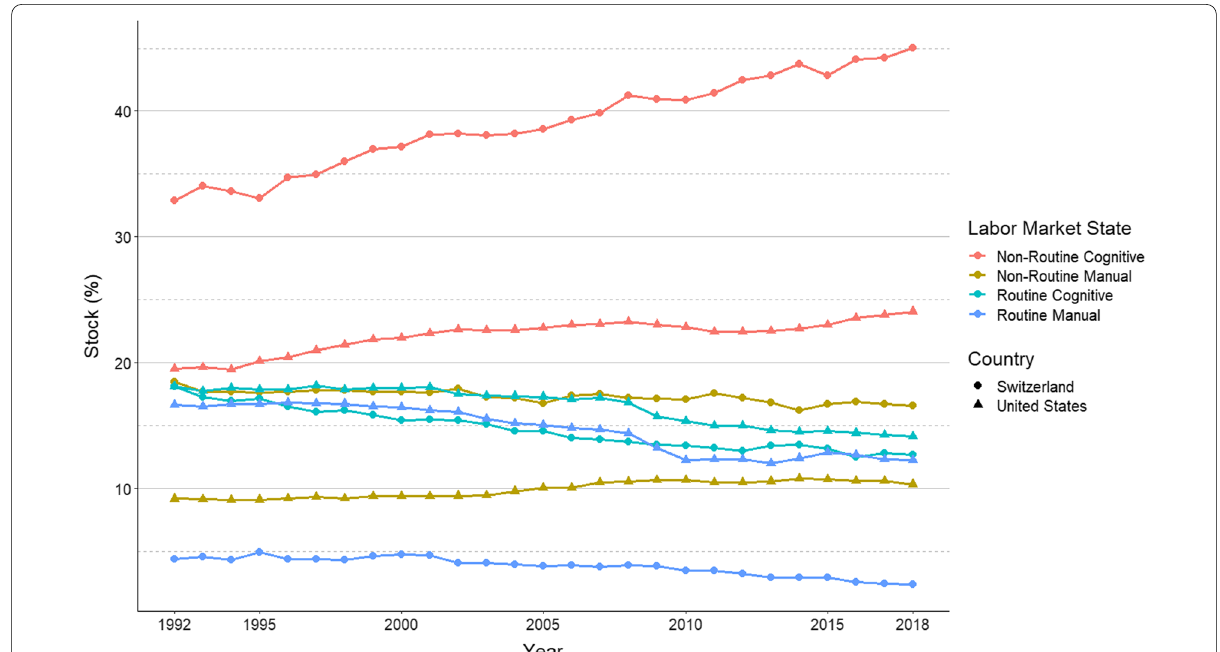
Fig. 4 Labor Market Stocks of Routine Employment, Switzerland and the USA. Source: Cortes et al. (2020), Swiss Labour Force Survey,